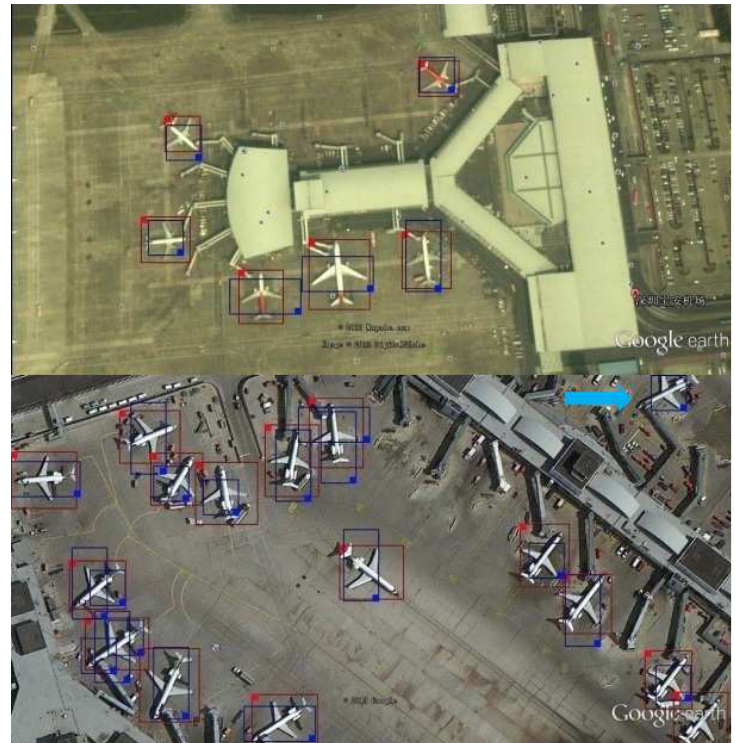
Figure 23. Examples of detection results on the SMALL-FIELD-RSI dataset.